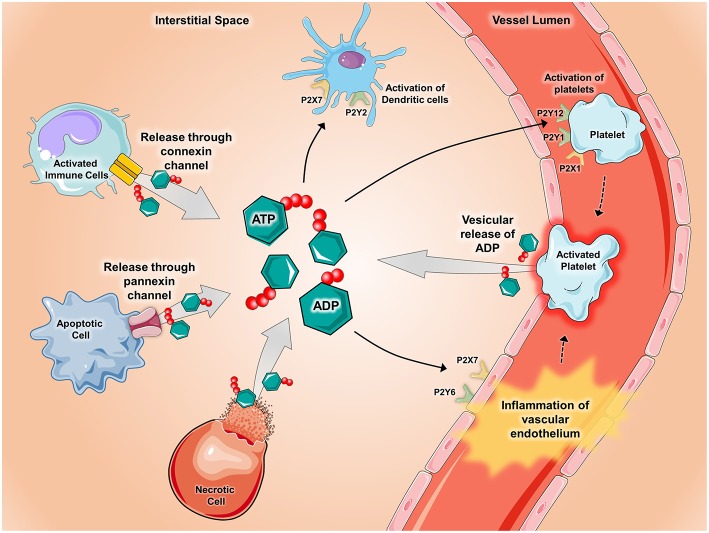
Release of ATP during inflammatory conditions. During conditions of inflammation such as during ischemia-reperfusion injury, hypoxia, inflammatory bowel disease, acute lung injury, and vascular thrombosis, ATP and ADP are released into the extracellular space via several mechanisms. ATP and ADP are released from apoptotic cells through pannexin-hemichannels and from connexin-hemichannels located on activated immune cells. Additionally, ATP and ADP can be released after cell lysis occurs in necrotic cells and though vesicular release by activated platelets. Once released, ATP and ADP act as potent signaling molecules by binding to and activating P2X receptors (ligand-gated ion channels) and P2Y receptors (G-protein-coupled receptors). Pictured are several examples of how ATP and ADP activate P2x and P2Y receptors during inflammatory states. P2Y6 and P2X7 receptors on vascular endothelium promote inflammation whereas activation of the P2X1, P2Y1, and P2Y12 receptors mediate platelet activation. In the setting of chronic lung diseases such as asthma, P2X7 and P2Y2 receptors promote activation of dendritic cells. Components of the figure were modified from SMART Servier Medical Art Library.